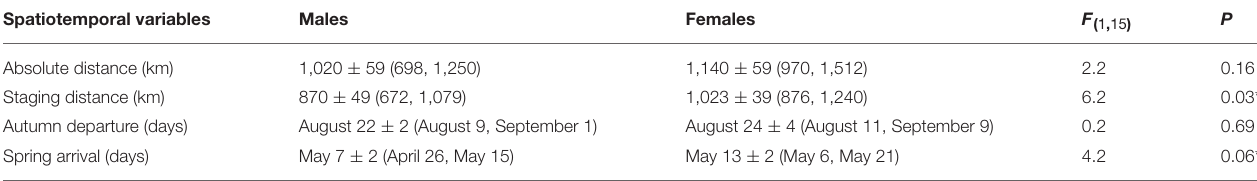
TABLE 2 | Analysis of Variance (ANOVA) results for sex-specific differences in spatial distribution and phenology during the non-breeding season.